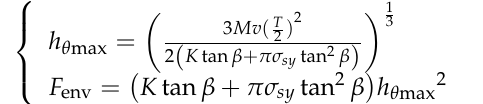
Figure 5. Schematic diagram of the machining trajectory of abrasive particles.